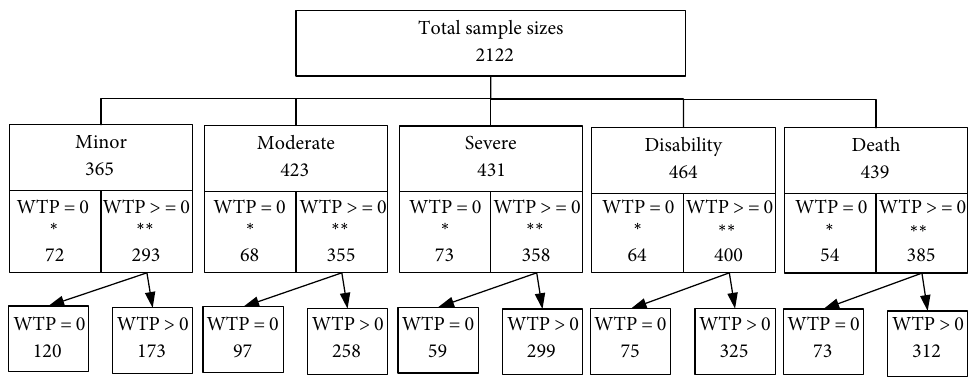
Figure 3: Sample sizes according to different scenarios (injury severity; with and without